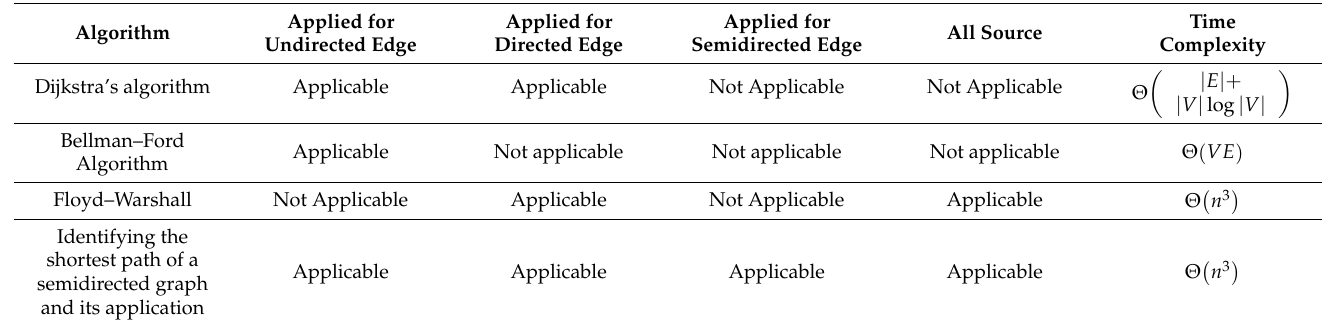
Table 4. Describing different SPAs (shortest path